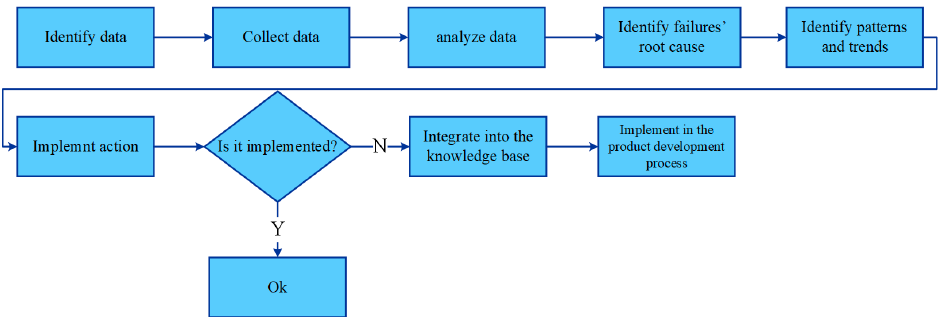
Figure 15. Workflow model to utilize data.